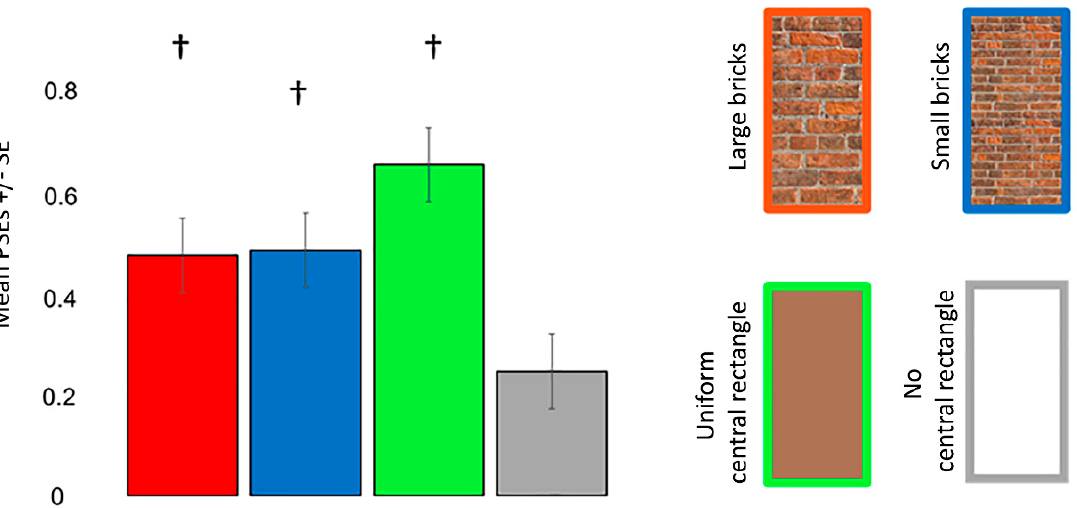
Figure 5. PSEs for the different Poggendorff stimuli in experiment 1. Daggers (†) denote differences from the no central rectangle condition at p < 0.050 after correcting for multiple comparisons using the Bonferroni method. PSEs were computed from psychometric functions. PSEs in left standard line blocks were multiplied by − 1 before the analysis. Error bars denote standard errors for within-subject contrasts as described by O’Brien and Cousineau [22].